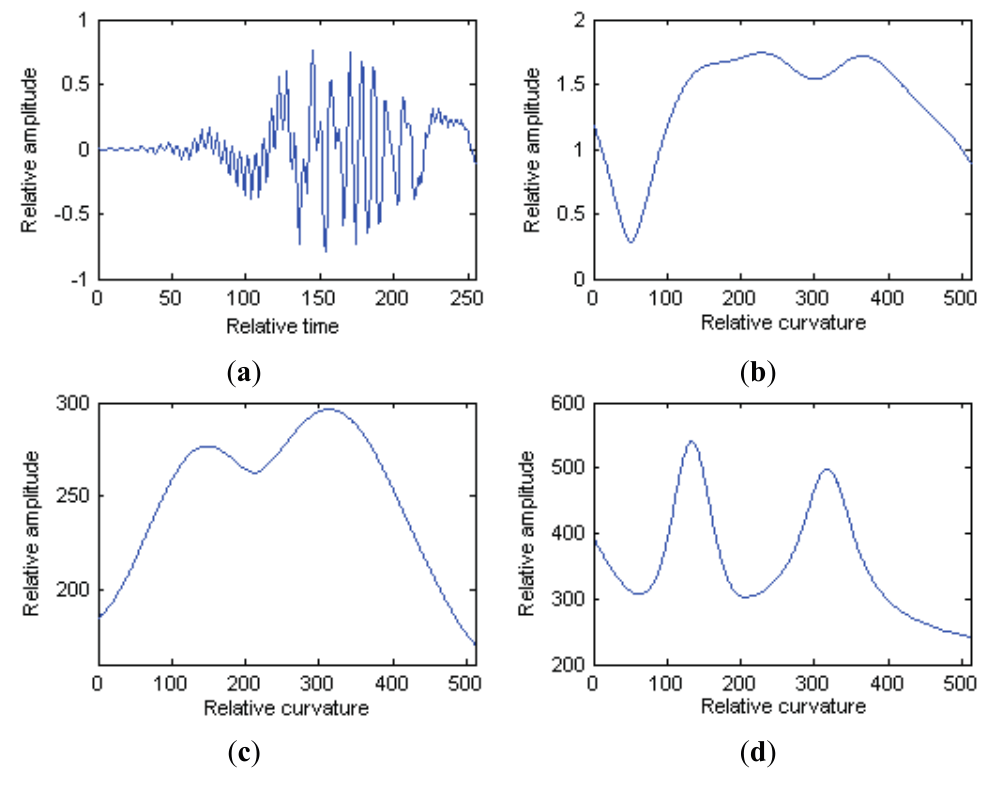
Figure 3. Results of the numerical example. ( a ) Simulated signal; ( b ) HAF for the signal; ( c ) IHAF with